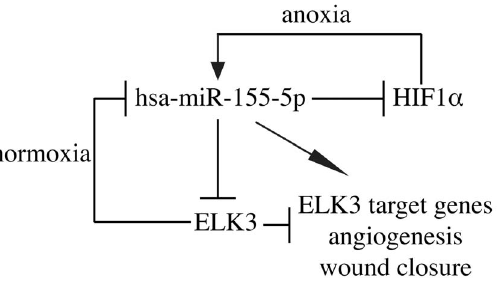
Figure 8. Model of the anoxia-ELK3-miR155 regulatory circuit. ELK3 blocks hsa-miR-155-5p expression in normoxia. Under anoxic conditions, hsa-miR-155-5p expression increases due to HIF1 a induc- tion, which in turn leads to decreased HIF1 a and ELK3 mRNA expression. Increased hsa-miR-155-5p expression and decreased Elk3 expression induce ELK3 target genes, angiogenesis and cell migration.